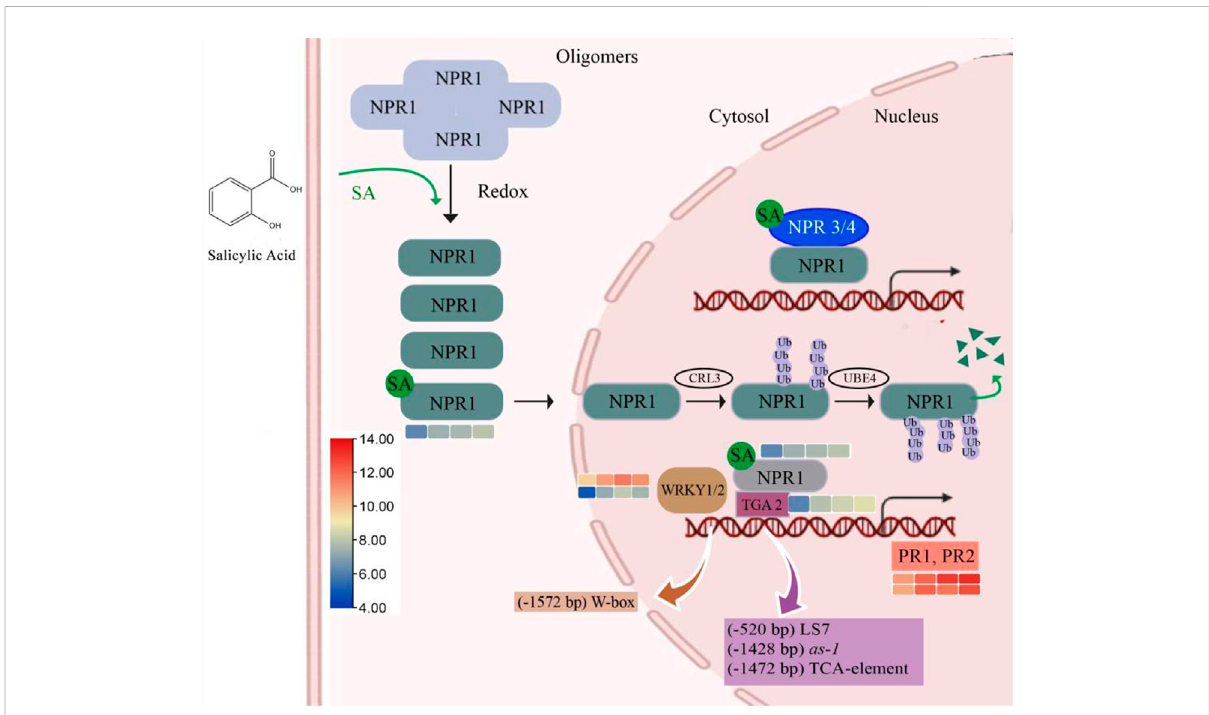
FIGURE 5 SA pathway related to plant defense. A higher SA level can induce the monomerization process of NPR1 and induced NPR1-dependent gene expression through direct interactions with TGA transcription factors. Meanwhile, direct binding with SA derepressed the suppression of NPR3 and NPR4onSA-inducedgenes,whichfurtherenhancedSA-inducedNPR1-dependentgeneexpression.Ef fi cientturnoverofmonomericNPR1proteins inthenucleusisrequiredforarate-limitedSA-induced